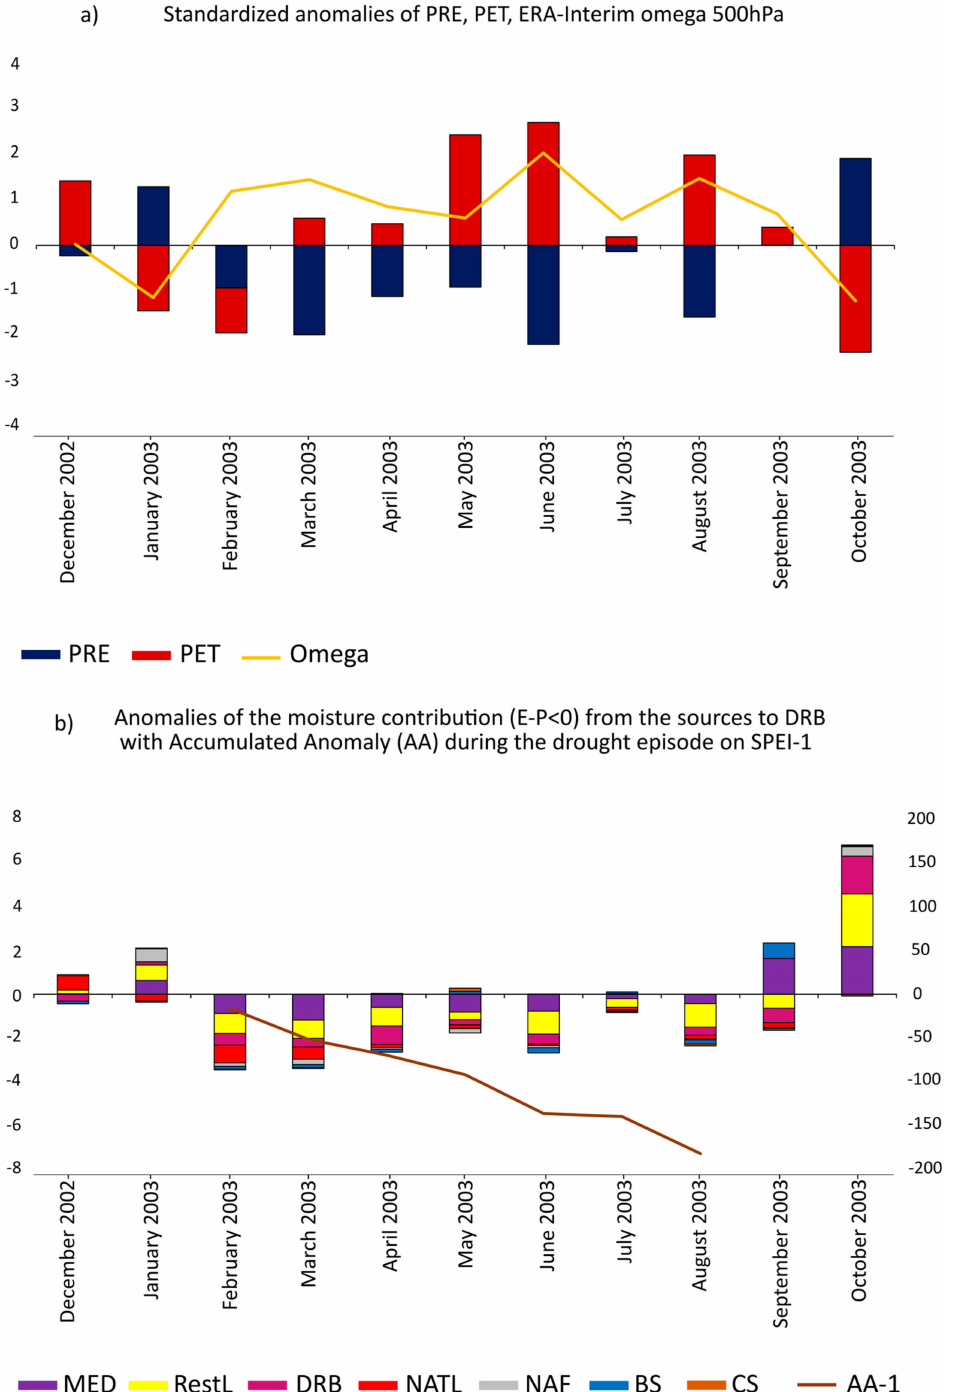
Figure 6. ( a ) Standardized anomalies of the precipitation (PRE, blue bars), potential evapotranspiration (PET, red bars) (data from Climatic Research Unit (CRU) Time Series (TS) 3.23), and ECMWF Re-Analysis ERA-Interim omega at 500hPa (omega 500, yellow line), and ( b ) Anomalies in the moisture supply (E – P < 0) (accumulated bars) by each source over the DRB obtained via the forward FLEXPART experiment (left axis, in mm/day) and the accumulated precipitation anomalies(brown line AA-1) (right axis, in mm/month) for the 2003 drought